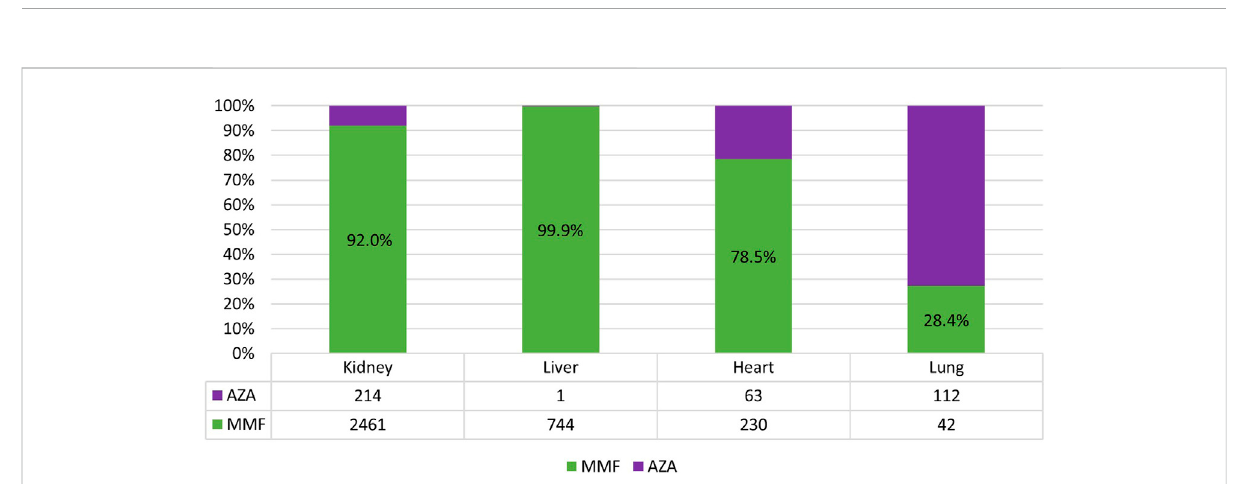
FIGURE 5 Percentage of mycophenolate (MMF) or azathioprine (AZA) use among antimetabolite